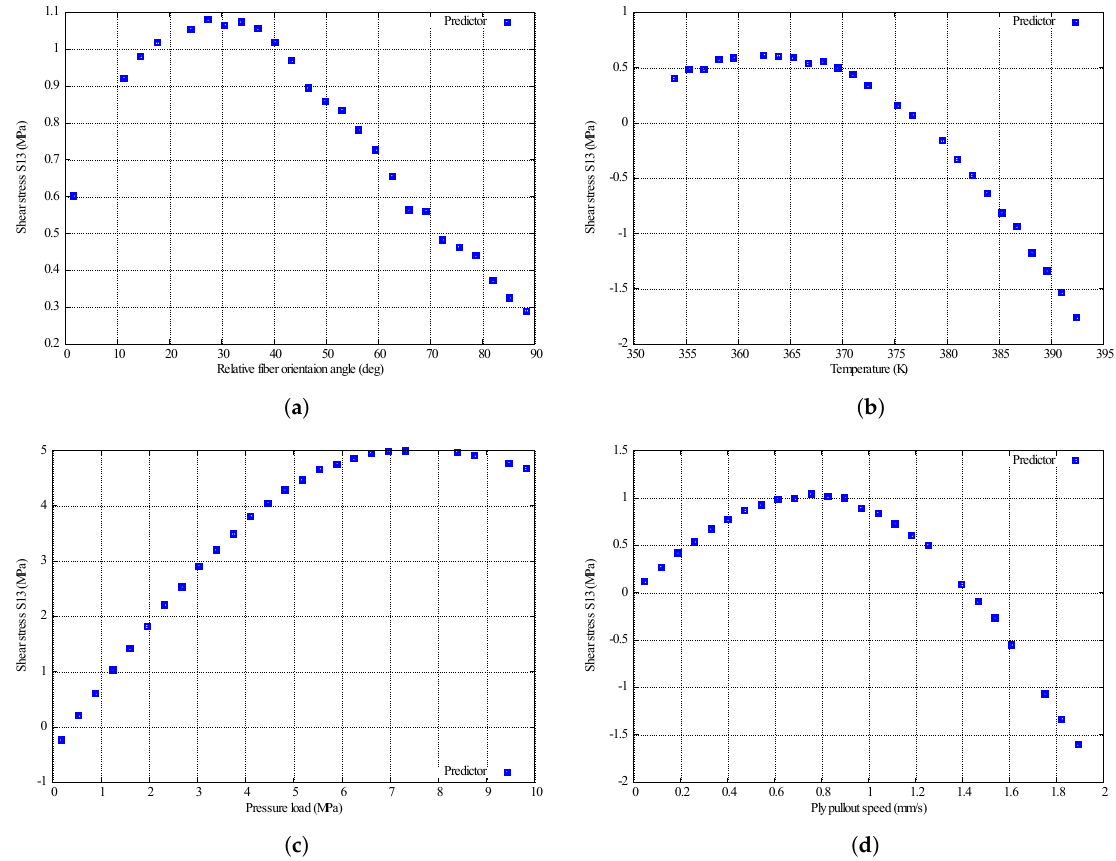
Figure 3. Effect of individual parameters on inter-ply shear stress. ( a ) Effect of relative fiber orientation angle. ( b ) Effect of forming temperature. ( c ) Effect of pressure load. ( d ) Effect of ply pullout